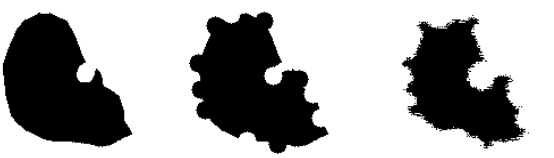
Figure 5. Ground truth-based initializations. Left: ground truth. Middle: distorted by added or punched semicircles at random border locations. Right: The middle image is corrupted by adding Gaussian noise and used as initialization for